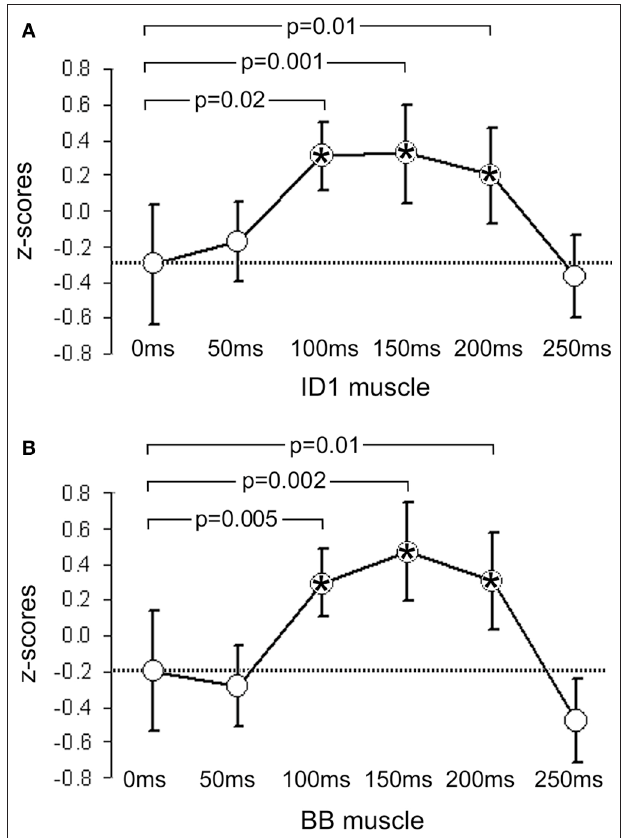
FIGURE 2 | Mean z -scores for each cry type and each ISI for females and males. Bars indicate 95% CIs. Asterisks indicate ISIs at which a significant difference was found with data obtained at 0ms